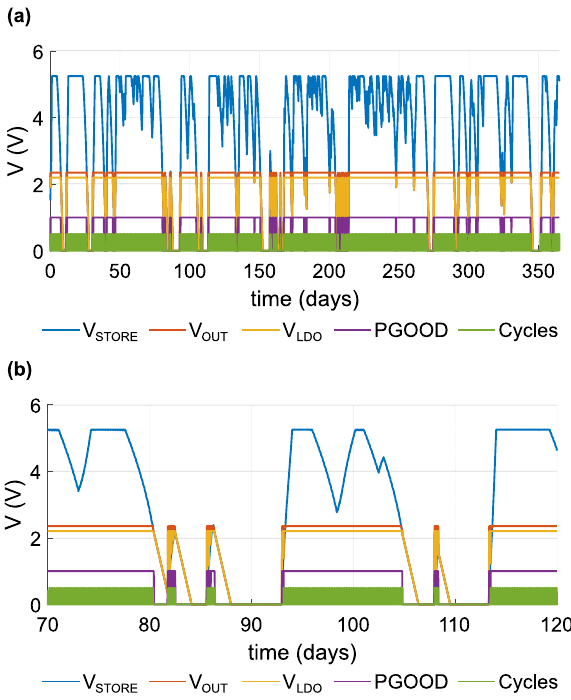
Figure 17. Graph of voltage levels; case I SLEEP = 15.3 µ A, T = 4 h. ( a ) One year; ( b ) detail of days 70–120.